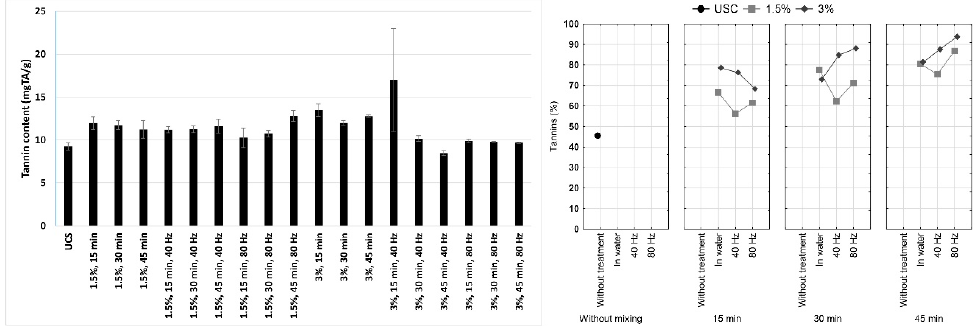
Figure 1. Tannin content (expressed on defatted sample weight) in cocoa shell before and after the high voltage electric discharge (HVED) treatment and percent of tannin in total phenols.